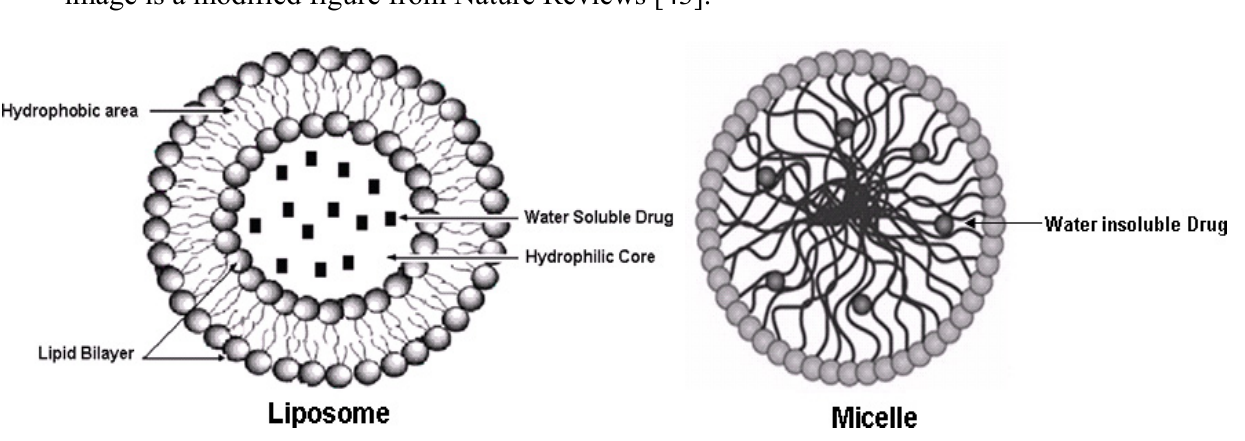
Figure 1. Two major loading models—Liposome and Micelle—for effectively loading water soluble and water insoluble natural chemopreventive agents, respectively. (Micelle image is a modified figure from Nature Reviews